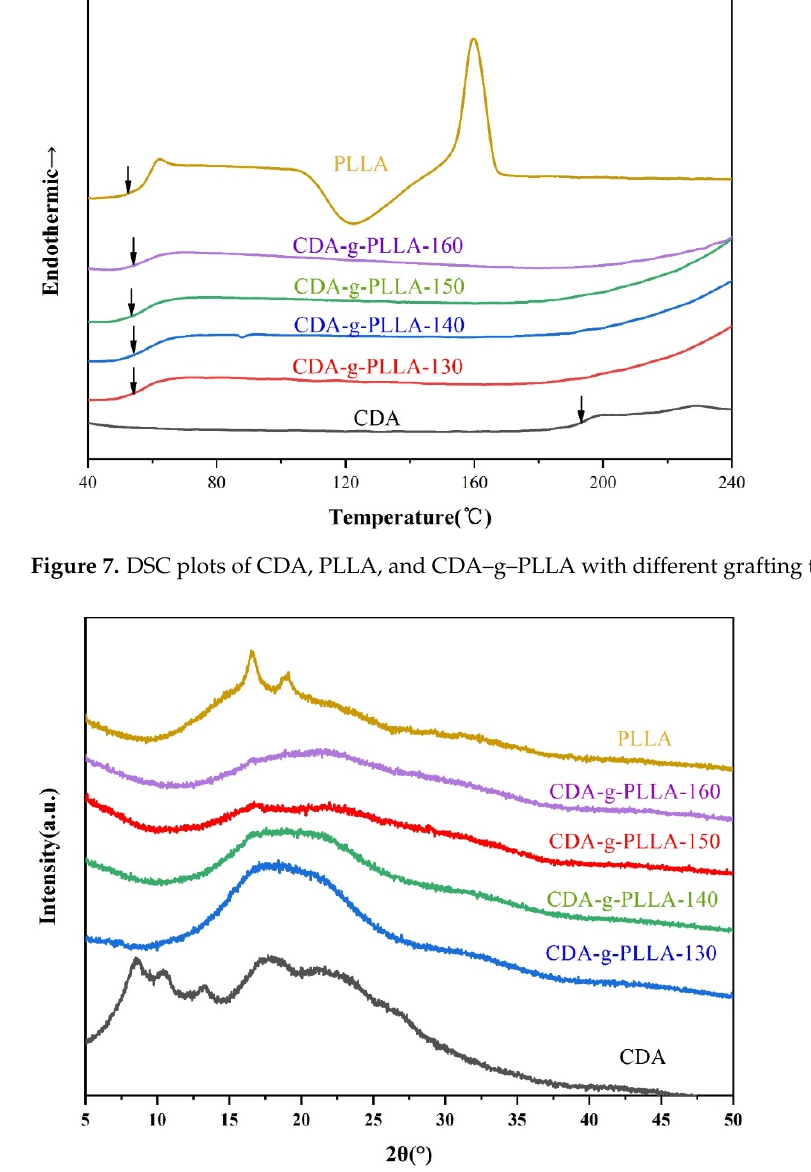
Figure 7. DSC plots of CDA, PLLA, and CDA − g − PLLA with different grafting temperatures.